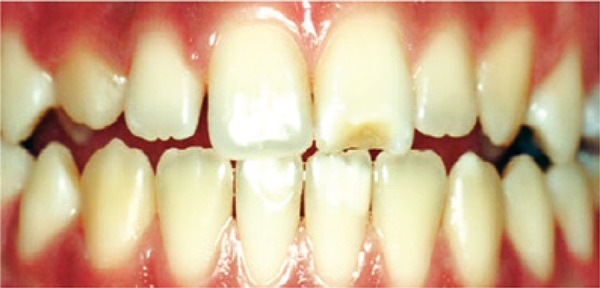
Dentes com hipoplasia do esmalte